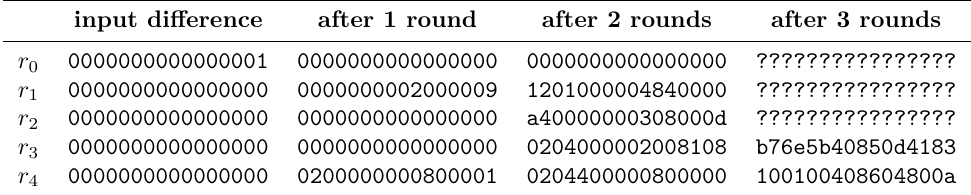
Table 23: Differential characteristic to create forgery for round-reduced Ascon-128 and Ascon-128a with a 3-round finalization. The differential probability is 2 − 32 . The breakdown of the probability (in − log ) is [2 , 16 , 2